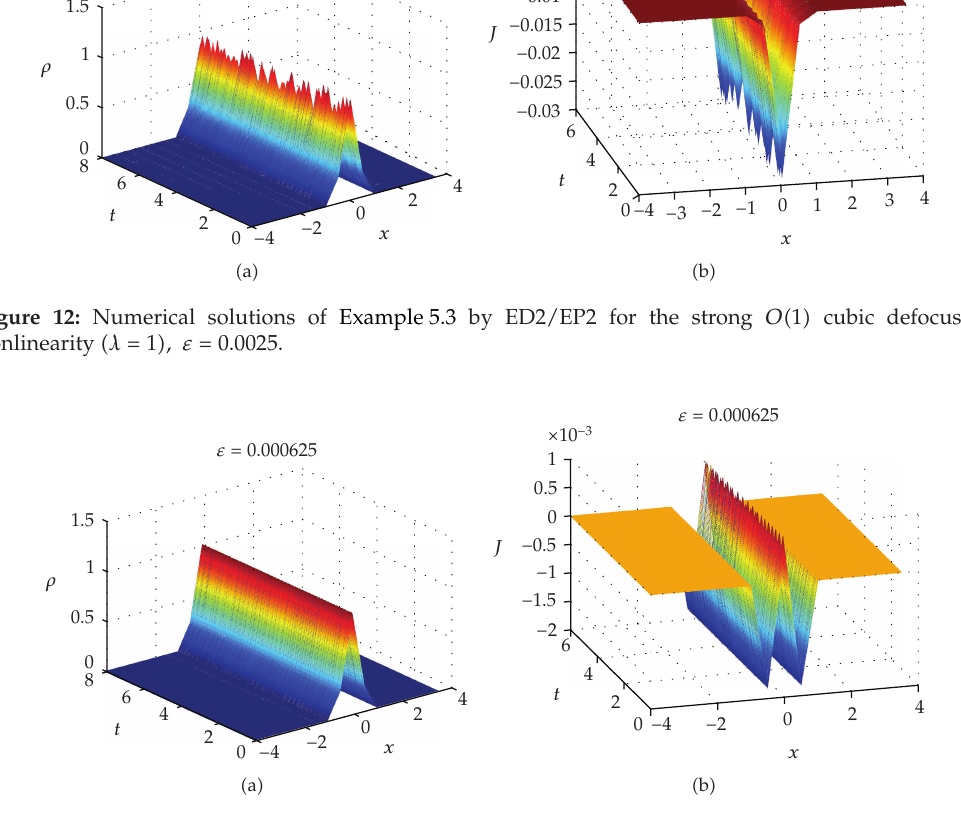
Figure 13: Numerical solutions of Example 5.3 by ED2/EP2 for the strong O (cid:3) 1 (cid:4) cubic defocusing nonlinearity (cid:3) λ (cid:6) 1 (cid:4) , ε (cid:6) 0 .